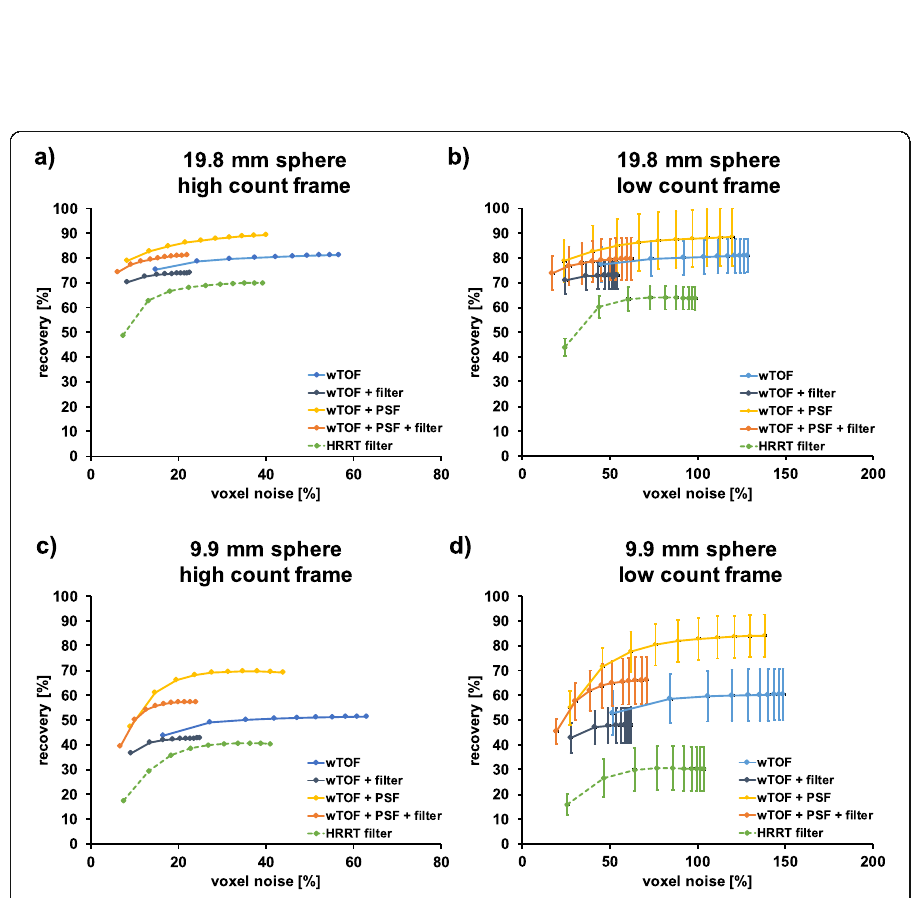
Fig. 3 PET/MR RCs (%) as a function of voxel noise (%) for two different sphere sizes and for a high and low count frame for the contrast phantom (19.8 mm sphere: high count frame ( a ), low count frame ( b ); 9.9 mm sphere: high count frame ( c ), low count frame ( d )). The high count frame corresponds to ~ 135 million prompts within the frame, the low count frame to ~ 12 million prompts. Note the difference in x -axis limits. PET/MR data were reconstructed with TOF, TOF with filter, TOF with PSF, and TOF with PSF and filter using 28 subsets, respectively. High count data were analyzed based on a single realization while low count data were based on five replicates. Each point represents an OSEM iteration, and the number of iterations increases from left to right. The dotted line represents the HRRT standard in-house reconstruction (2-mm Gaussian filter) used for human data